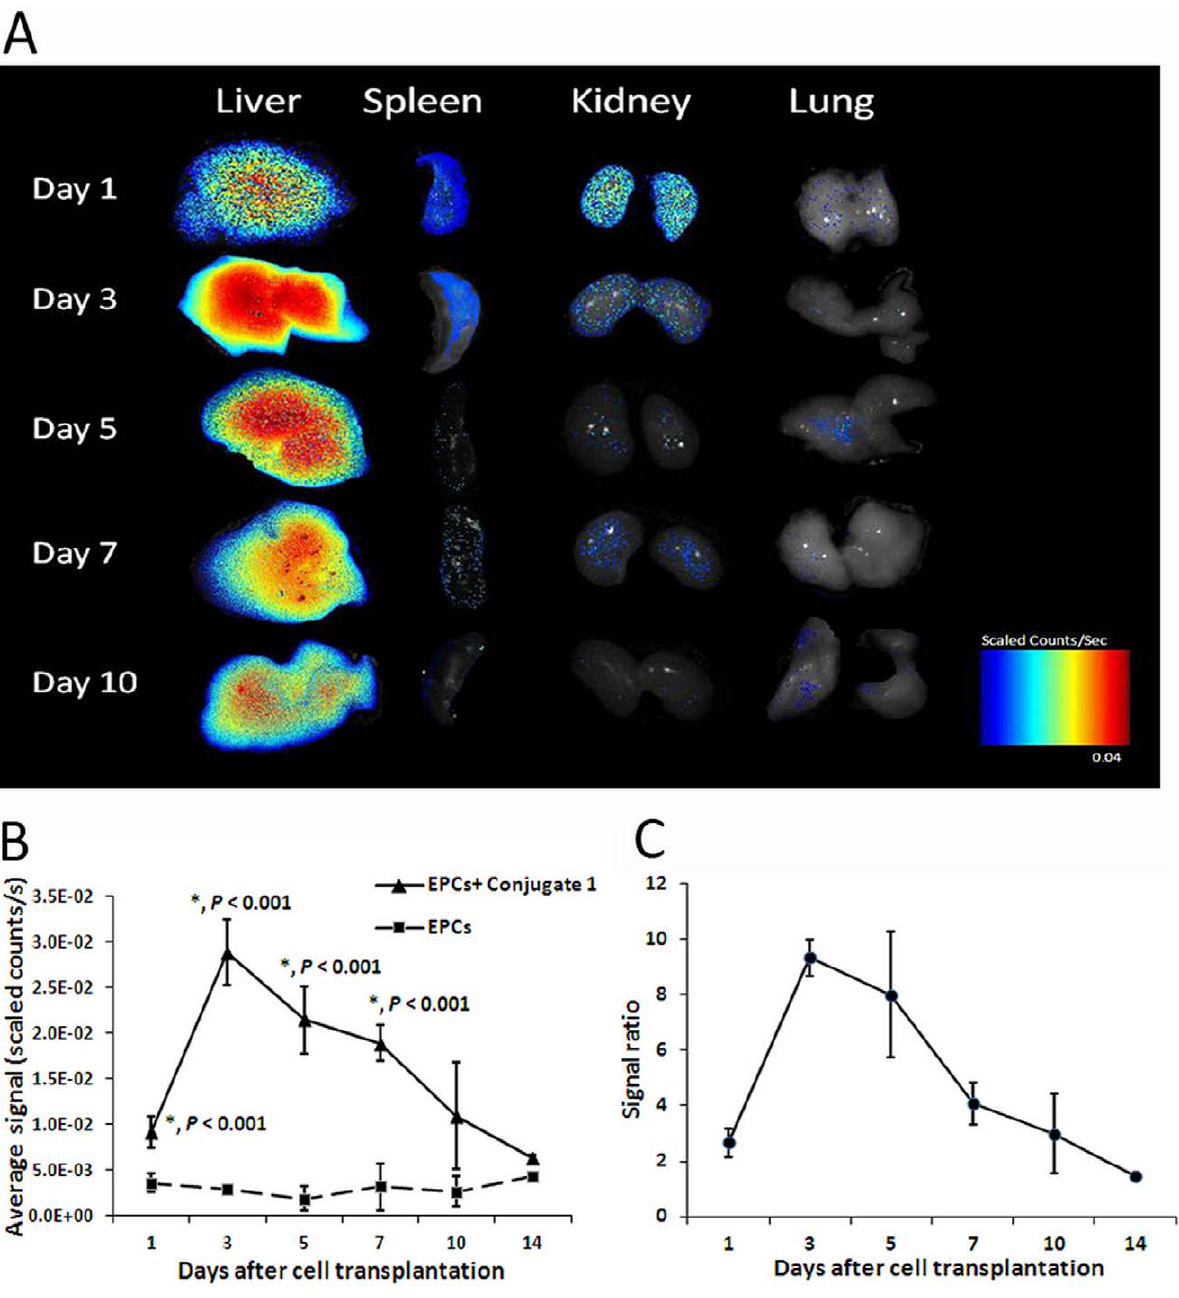
Figure 4. Exvivo NIR imaging of other organs. (A) Color-coded fluorescence images indicated that strong signal enhancement in the liver persisted from day 3 to day 7. Weak signals were detected from other organs at day 1 and 3. (B) The levels of liver signal intensity of group 1 and 2 were shown. Significant fluorescence intensity differences in the liver between group 1 and 2 were observed from day 1 to day 7 ( p , 0.001, n =3). The peak value was detected at day 3. (C) The liver signal ratio between group 1 and 2 was 9.34 6 0.68 at 3 days post transplantation of